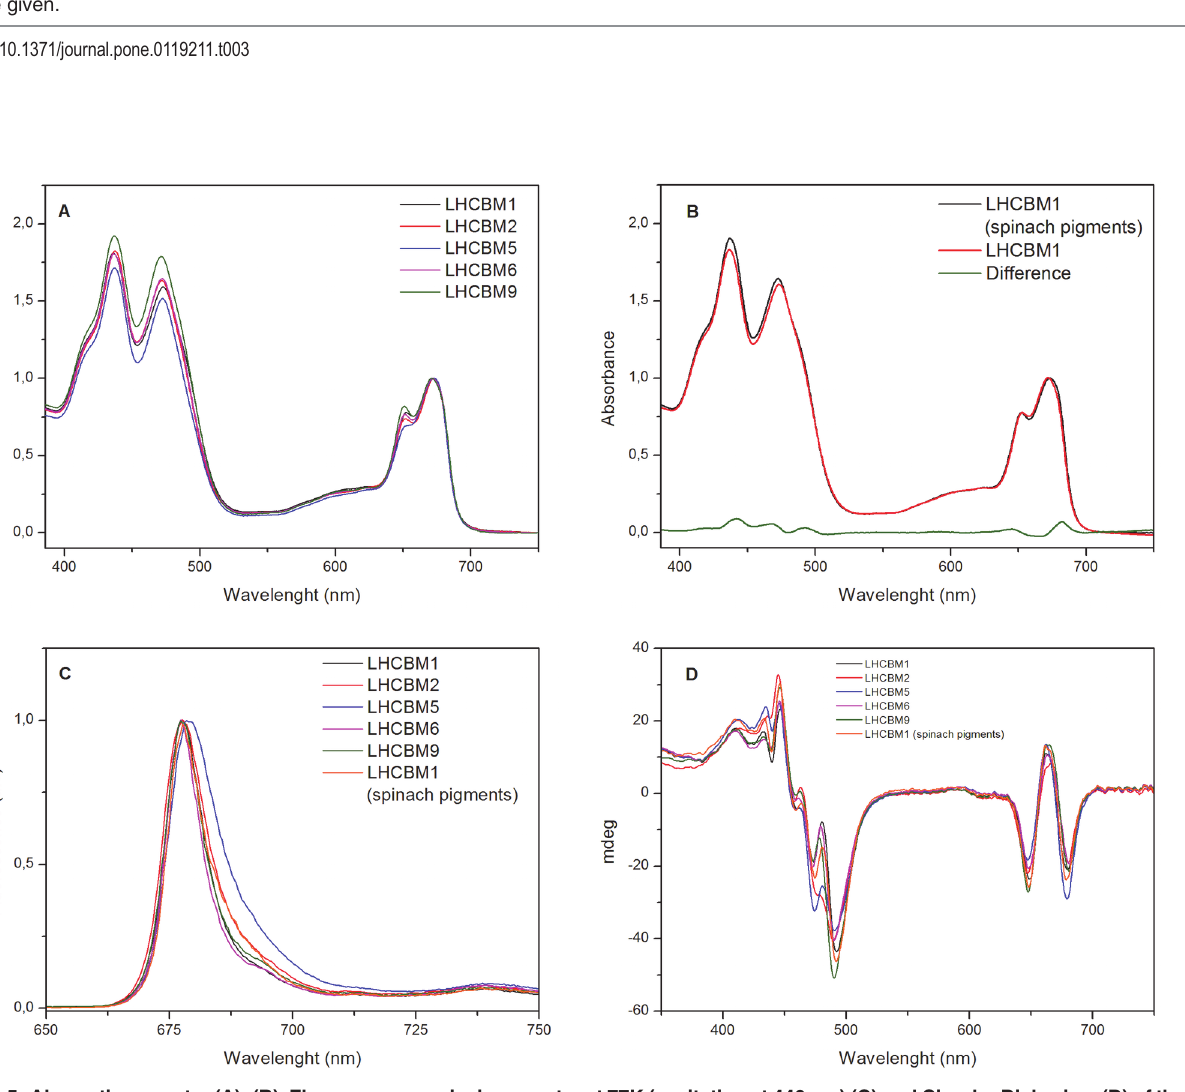
Fig 5. Absorption spectra (A) – (B), Fluorescence emission spectra at 77K (excitation at 440 nm) (C) and Circular Dichroism (D) of the LHCBM reconstituted complexes. The absorptions are normalized to the Q y peaks. Fluorescence emission spectra are normalized to the maximum, while the CD signals are normalized on the absorption